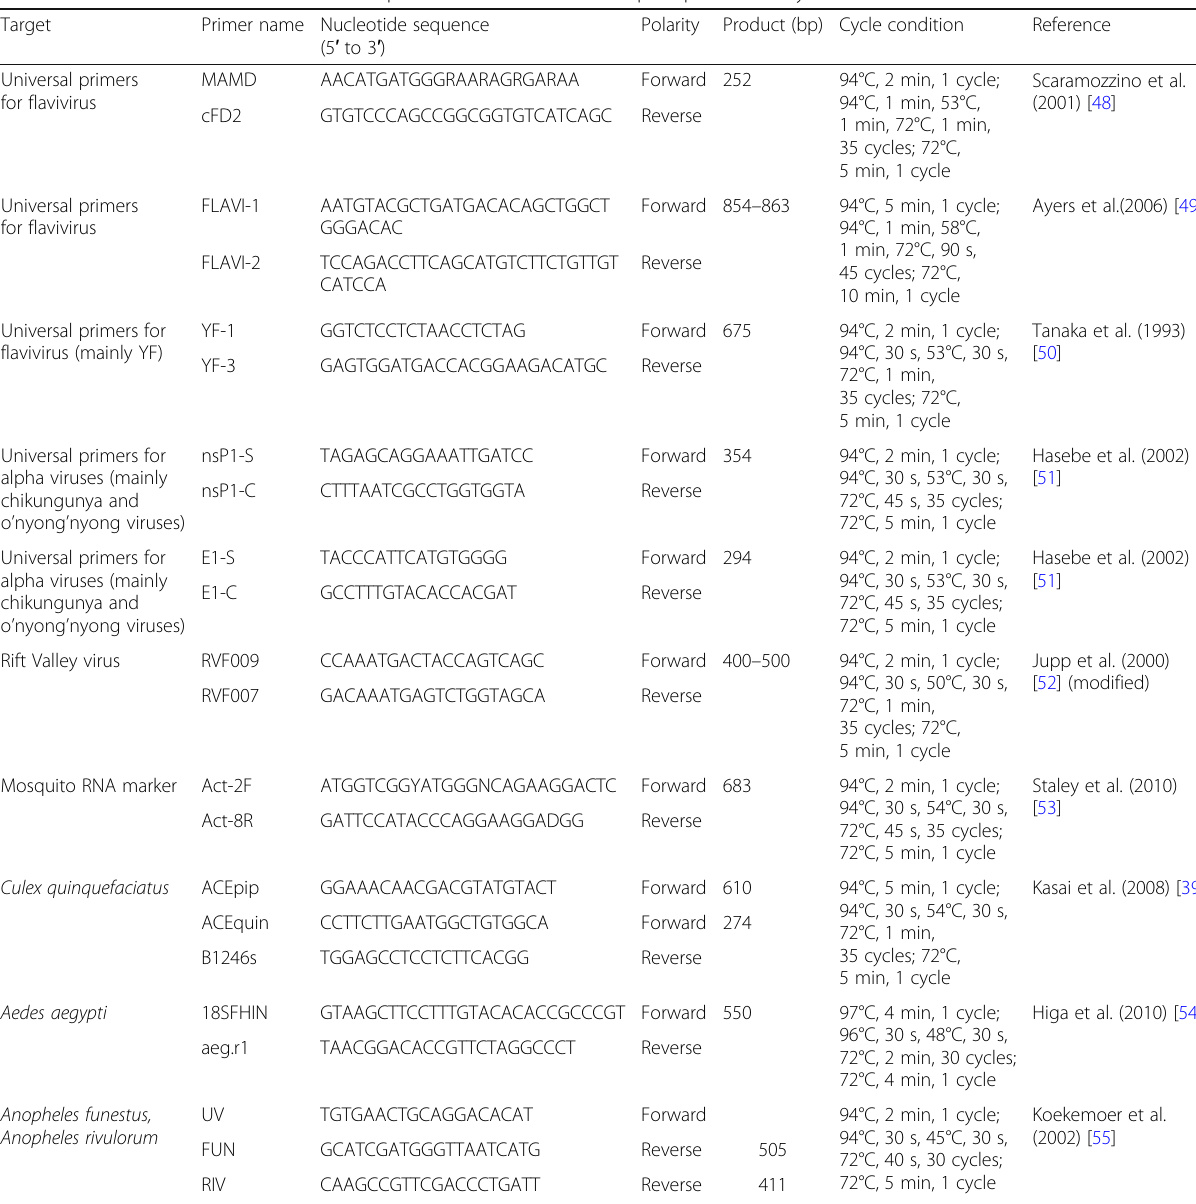
Table 1 Primers used to detect and to sequence arbovirus from mosquito pools in Kenya Target Primer name Nucleotide sequence (5 ′ to 3 ′